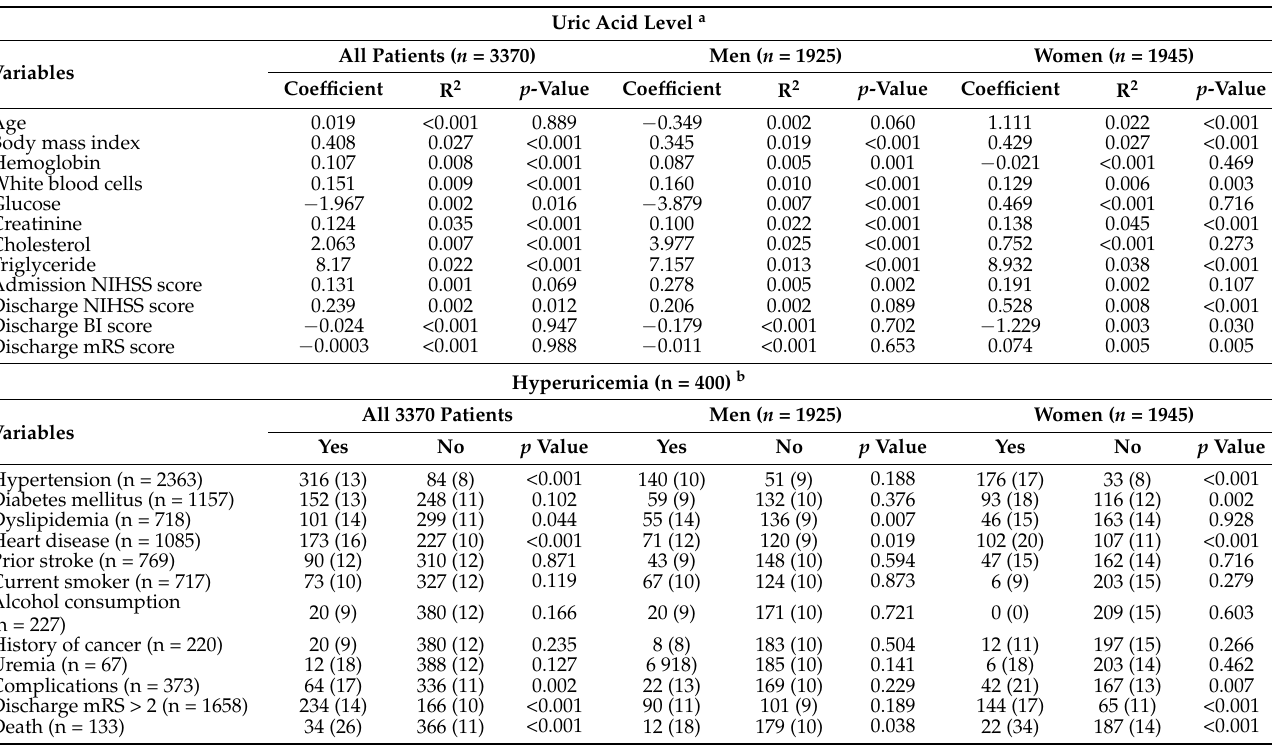
Table 5. Correlation of serum uric acid level and hyperuricemia with measured variables and outcomes in 3370 patients with acute ischemic